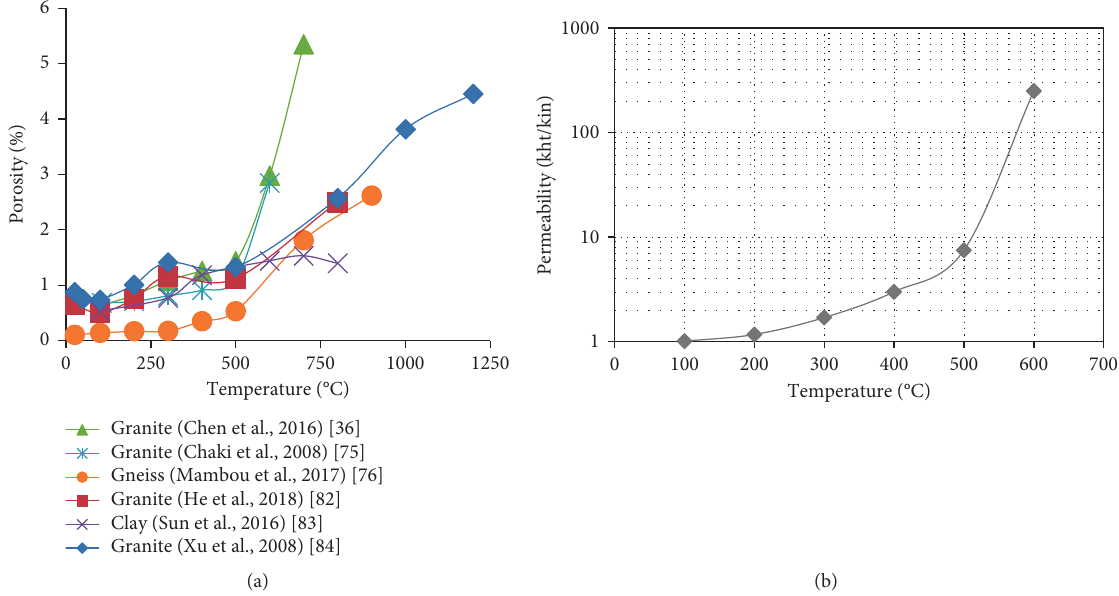
Figure 2: (a) Porosity of gneiss, granite, and clay with temperature. (b) Permeability of granite depending on temperature